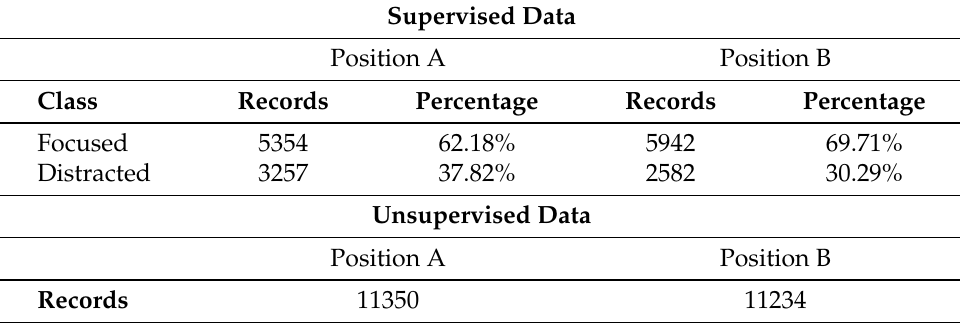
Table 1. Datasets